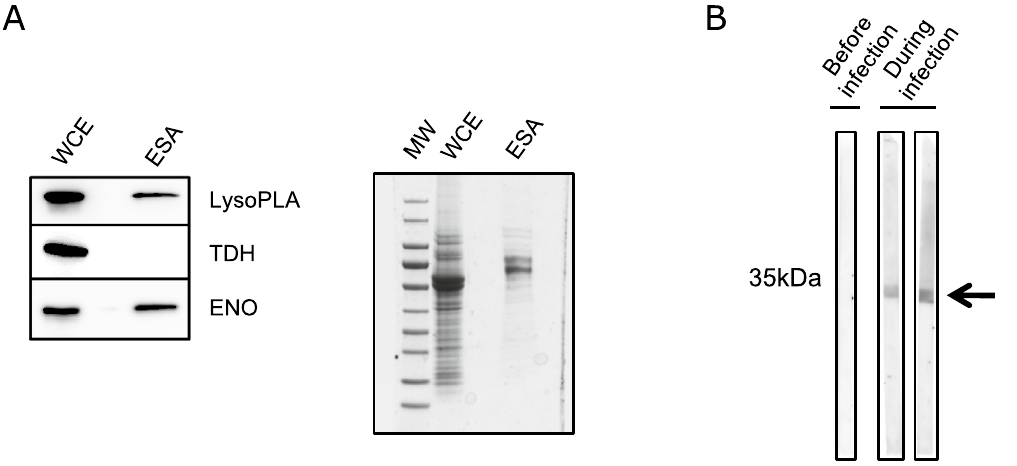
Figure 5. TbLysoPLA as a potent excreted/secreted factor. ( A ) Left: detection of LysoPLA in whole cell extract (WCE) of WT Tb BSF and in excreted/secreted material antigens (ESA). Specific anti-TbLysoPLA was used for detection, enolase was the positive control and TDH was used as a negative control. Right: commassie stating showing WCE and ESA. ( B ) Antibodies directed against TbLysoPLA are produced during infection Recombinant full-length TbLysoPLA was resolved by SPS-PAGE followed by a Western Blot. Mice serum taken before and during infection by T.b gambiense were used as primary antibody. Signal is detected only during infection